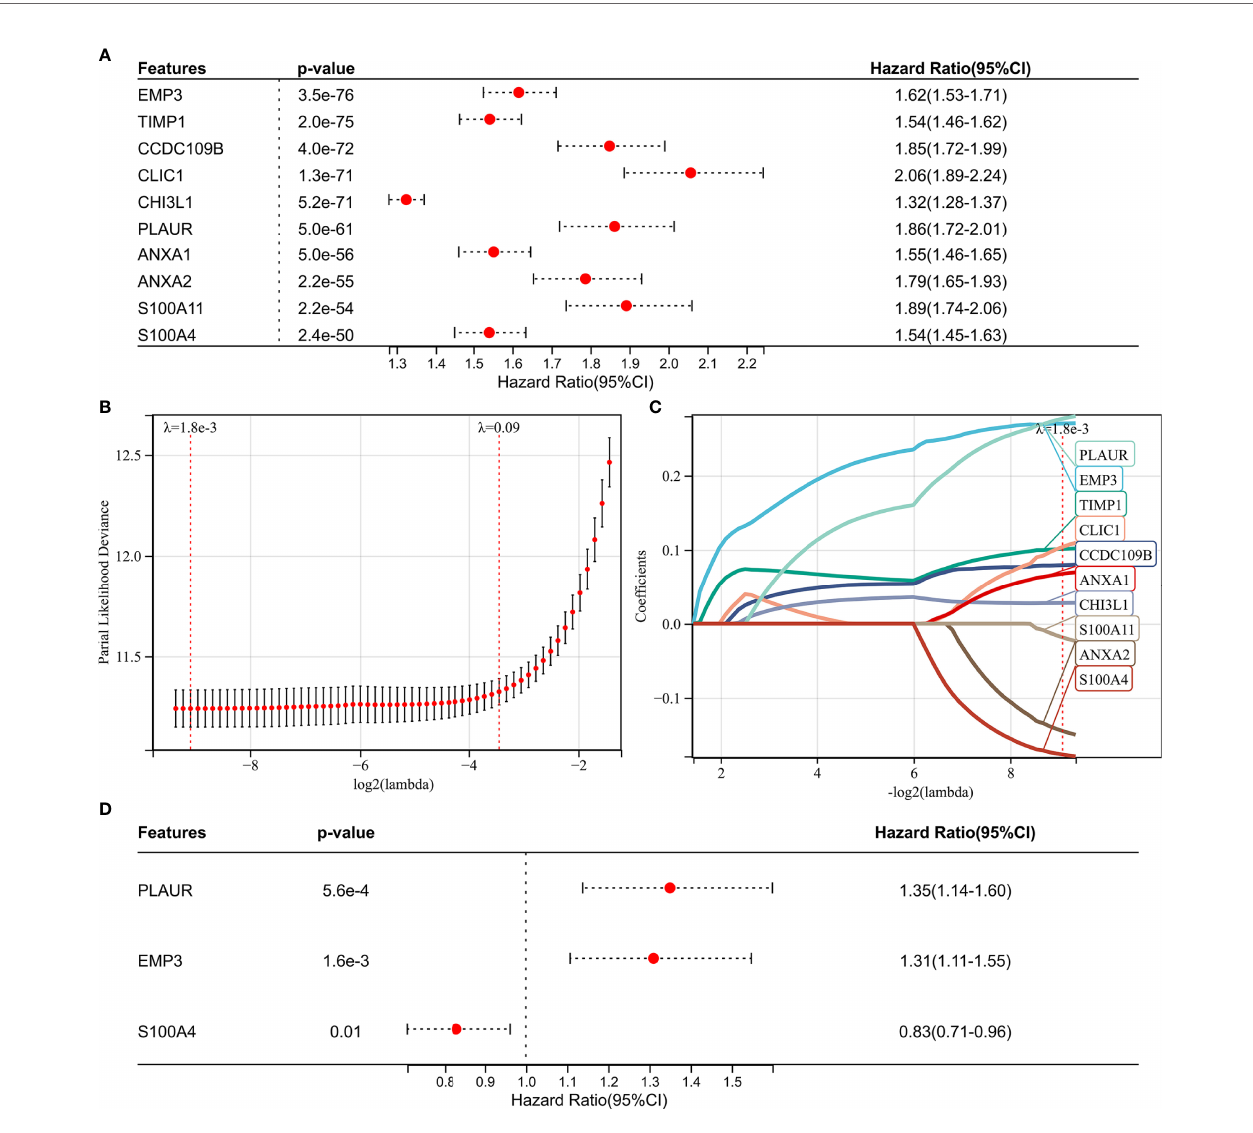
FIGURE 5 | Screening of the prognostic genes in TCGA GBMLGG cohort. (A) Univariate Cox regression analysis of hub genes in TCGA GBMLGG cohort. (B) Partial likelihood deviance of different numbers of variables revealed by the LASSO regression model. (C) LASSO coef fi cient pro fi les of the positive hub genes. (D) Multivariate Cox regression analysis of hub genes in TCGA GBMLGG